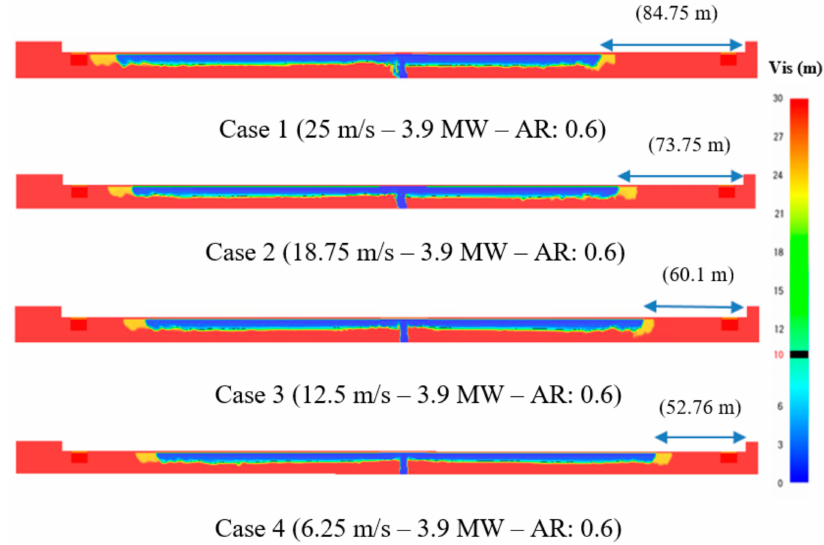
Figure 6. Visibility in the tunnel when changing the jet fan